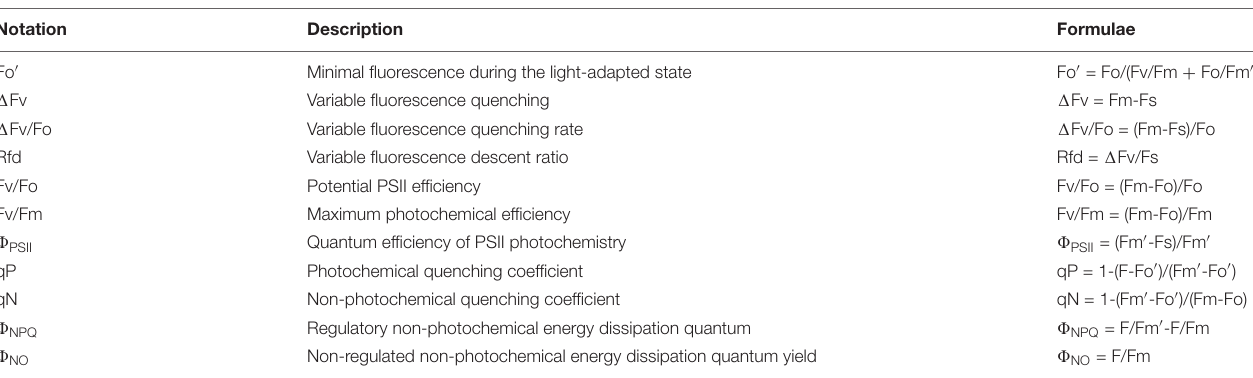
TABLE 2 | Legends and formulae for the calculation of chlorophyll fluorescence